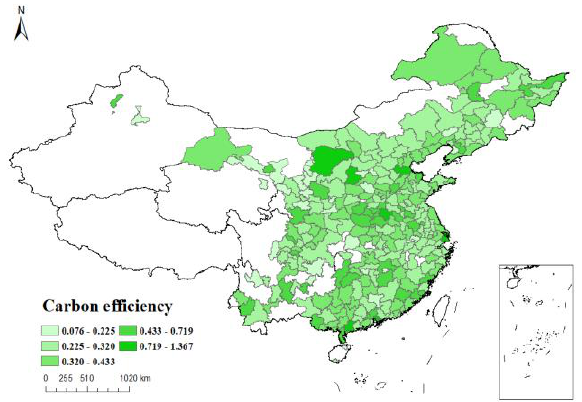
Figure 3. Carbon efficiency distribution of cities in China (2006).